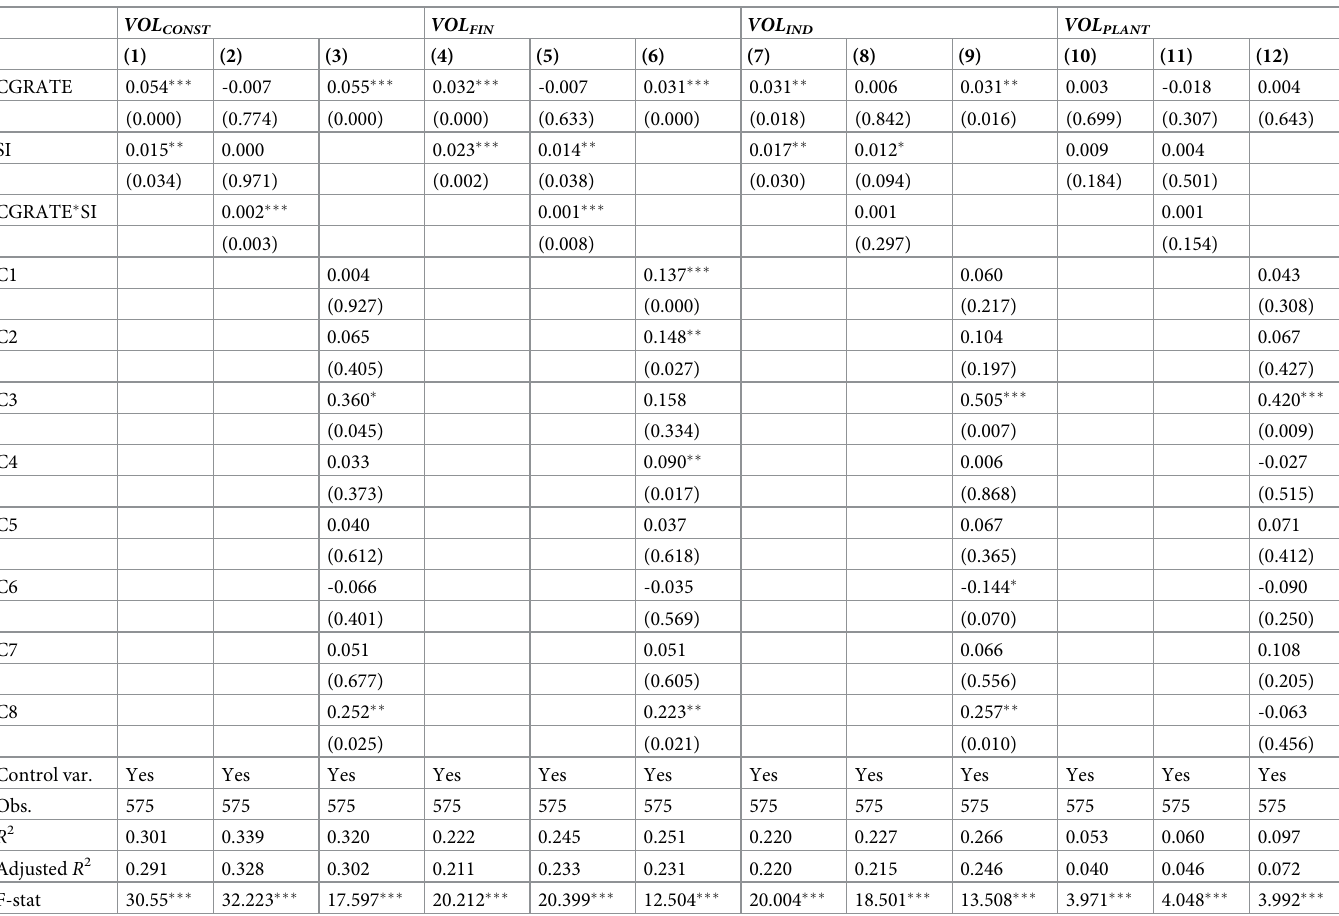
Table 7. Robustness tests: Alternative dependent variables using different sector indices